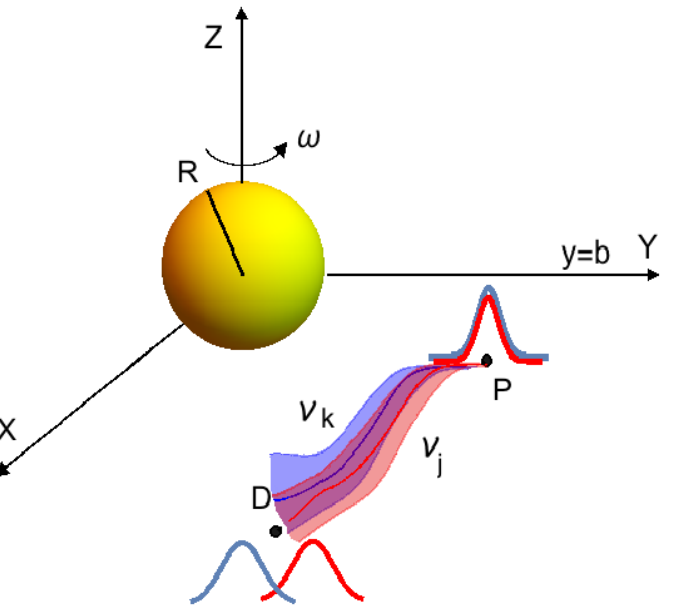
Figure 1. Pictorial representation of a neutrino propagating in the gravitational field of a spinning spherical body from the production point P to the detection point D, where the WPs can still interfere. We are assuming that each eigenstate WP follows a trajectory close to null-geodesics. The (online) colored widths represent the distribution of the trajectories due to the WP finite